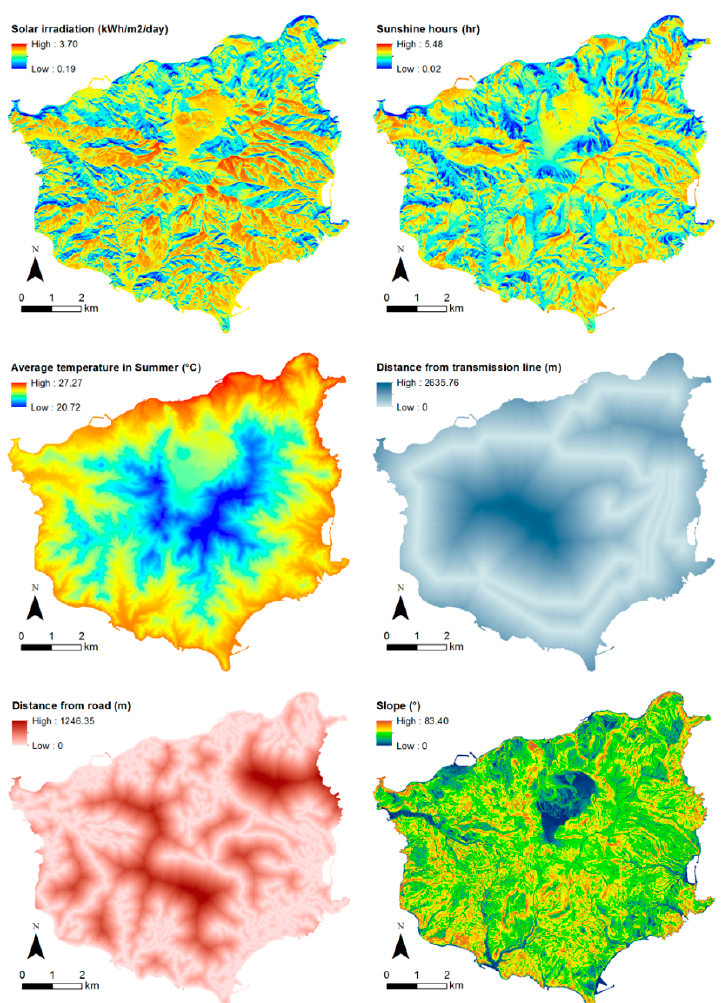
Figure 4. Factor layer inputs to identify a suitable area for PV installation on Ulleung Island (Suh and Brownson [49]).